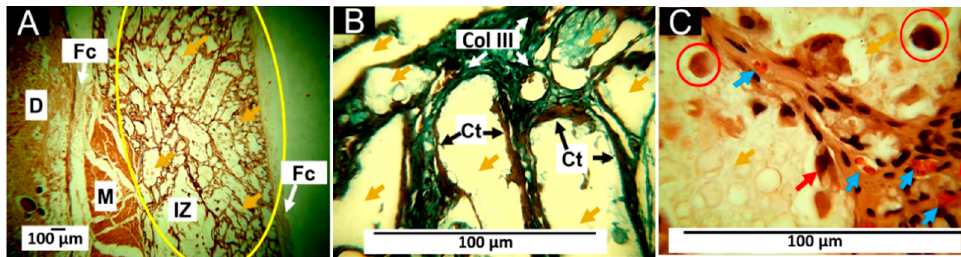
Figure 11. Subdermal implantations of F1 (25%PCL/70%PLA/5%Gly) at 60 days. ( A ): Formulation F1 at 4× HE technique. ( B ): Formulation F1 at 40× GT technique. ( C ): Formulation F1 at 100× HE technique. D: Dermis. M: Muscle. Fc: Fibrous capsule. IZ: Implantation zone. Yellow oval: Implantation area. Col III: Collagen type III. Ct: Connective tissue. Yellow arrows: Fragments of material F1. Red arrows: inflammatory cells. Blue arrows: blood vessels. Red circles: multinucleated cells. HE: Hematoxylin and Eosin technique. GT: Gomori Technique.